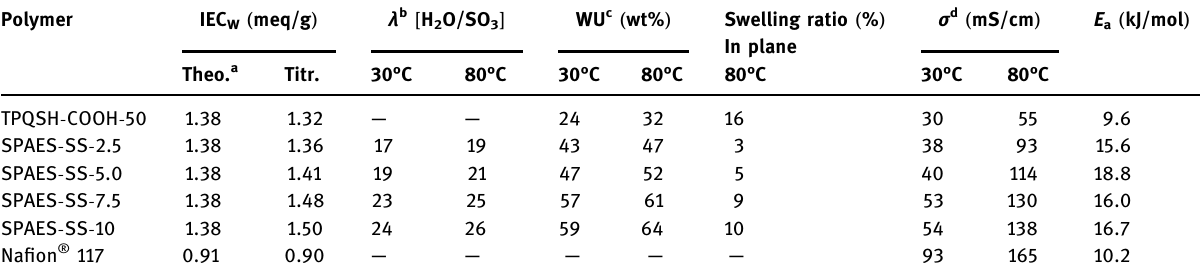
Table 2: IEC W , hydration number, water uptake, and proton conductivity of pristine copolymer, SPAES - SS - X composite membranes, and Na fi on ® 117 Polymer